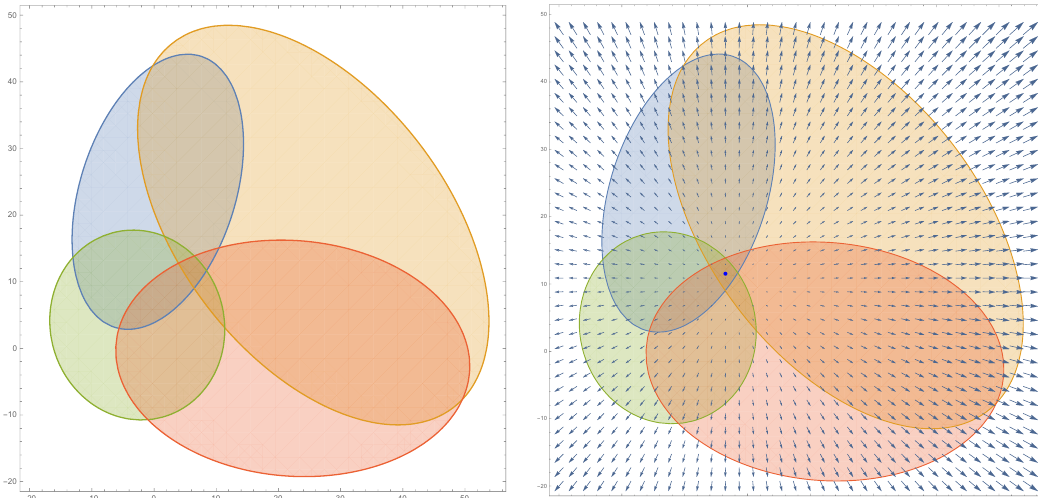
Figure 4. A correct deformation using the radial (cid:12)eld ~k in the interior of all four